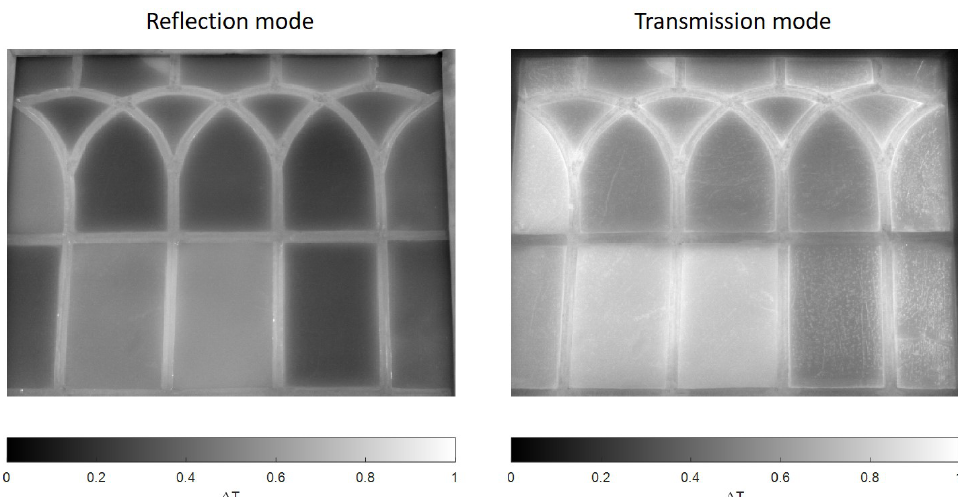
Figure 4. Comparison of the reflection ( left ) and transmission ( right ) mode at the start of the cooling-down process. Scratches and corrosion is more prominent in transmission